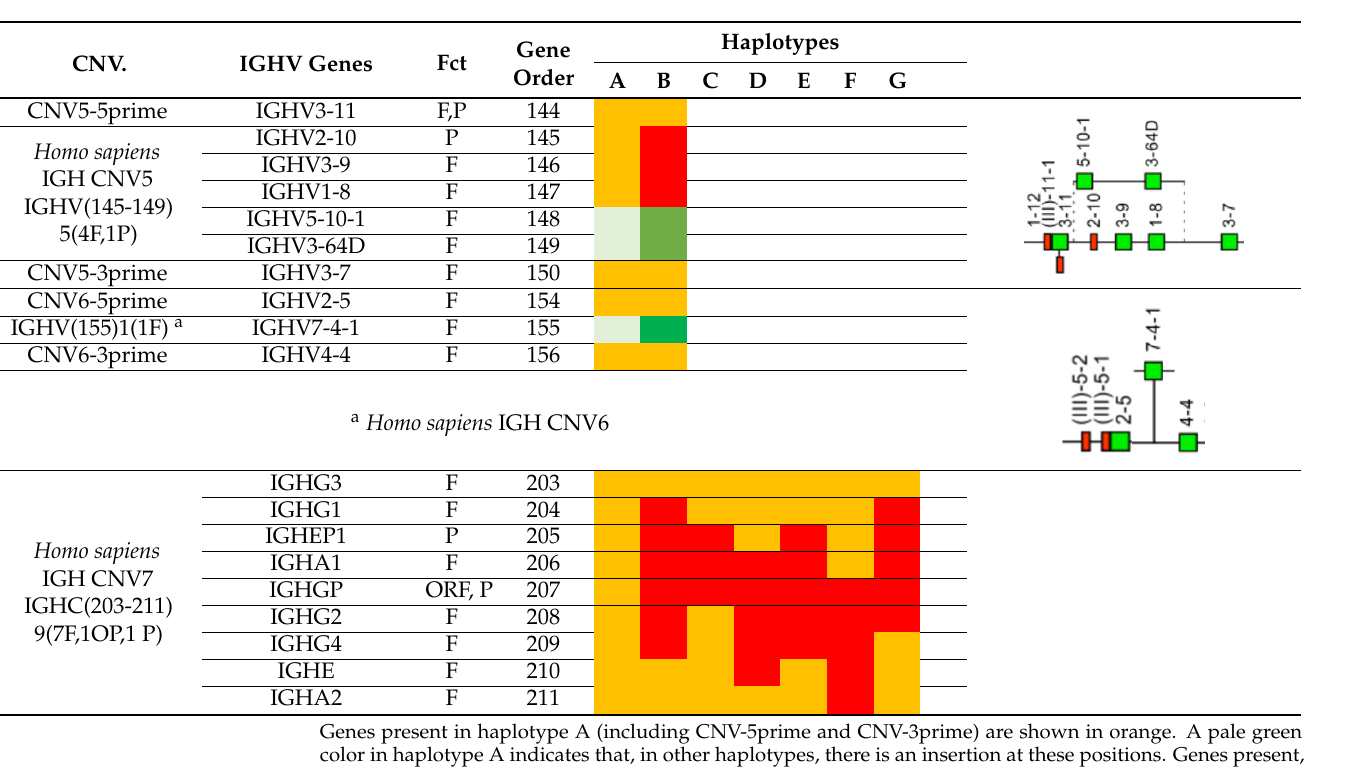
G (Table 4), with six of them (haplotypes B to G) corresponding to multigene deletions I to VI (Figure 6), identified on both chromosomes 14 in healthy individuals lacking